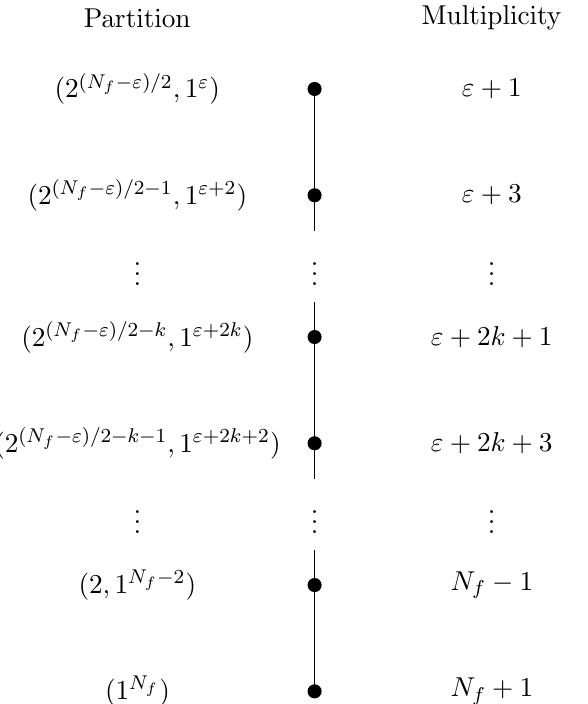
Figure 21 . The height two part of the Hasse diagram of the sl ( N f , C ) nilpotent orbits, with associated conjectured orbit multiplicities in the Hilbert series for pure mesonic Higgs branches. Here ε = 0 if N f is even and ε = 1 if N f is odd.